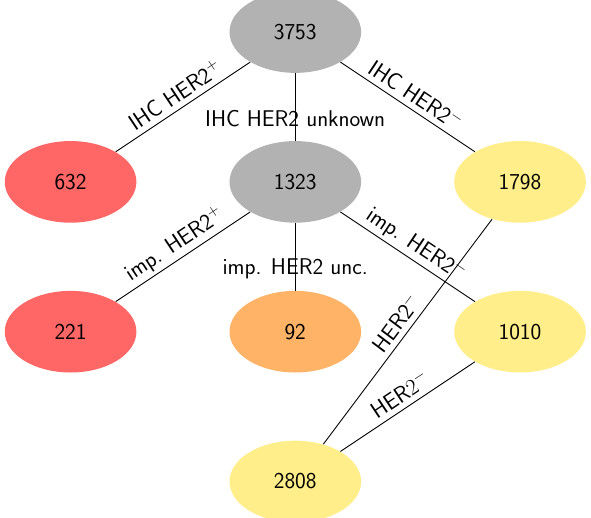
Figure 1. Selection of HER2-negative (HER2 − ) samples. The sODDS-method 57 was applied to 3753 patient samples to extract those HER2 – . If IHC receptor status was available, it was taken as is and samples accepted (1798 HER2 – , yellow) or excluded (632 HER2 + , red). Patients with unknown IHC-status (1323, grey) were accepted if HER2 – could be safely imputed (imp. HER2 - ) by the ODDS method (1010, yellow) and excluded if ODDS safely yielded HER2 + (221, red) or ‘uncertain’ (imp. HER2 unc., 92, beige). All in all, 1798 + 1010 = 2808 HER2 - patients